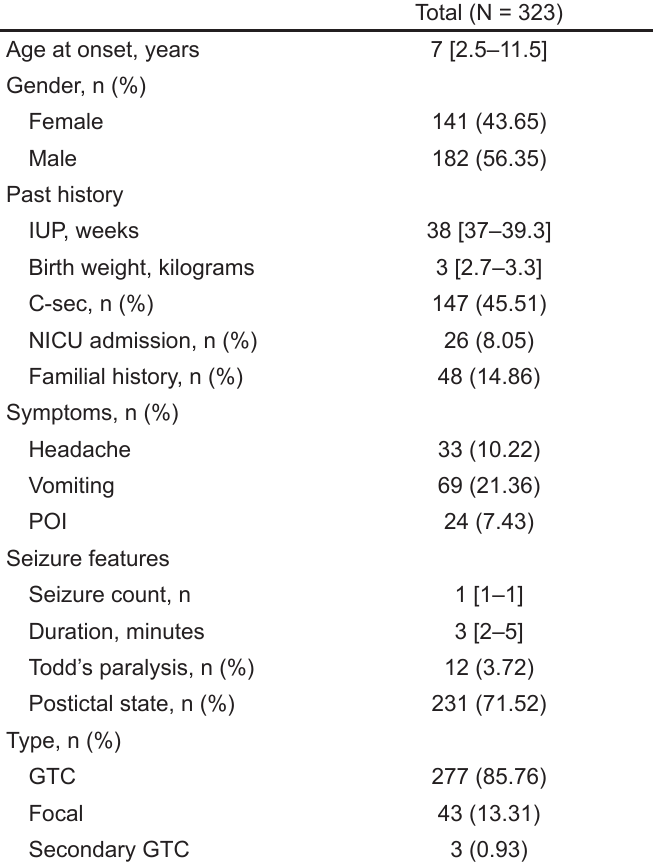
Table 1. Baseline characteristics of pediatric patients with afebrile